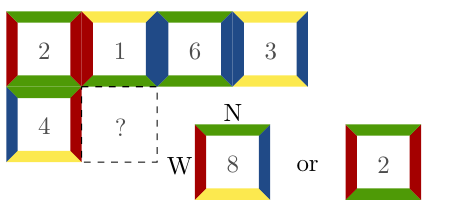
Figure 4. Tiling process and valid tiles for the corner position. Figure 5. Smallest Wang tiles set called